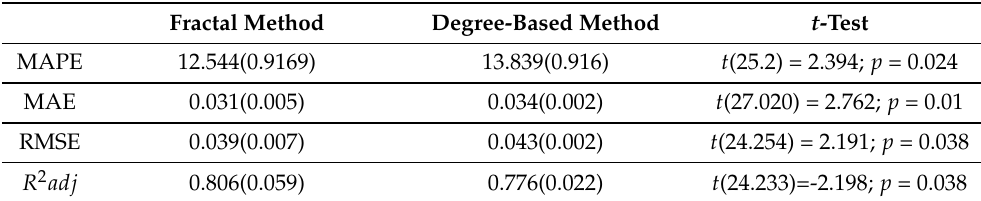
Table 4. The MAPE, MAE, RMSE, and R 2 adj µ ( σ ) of AURC